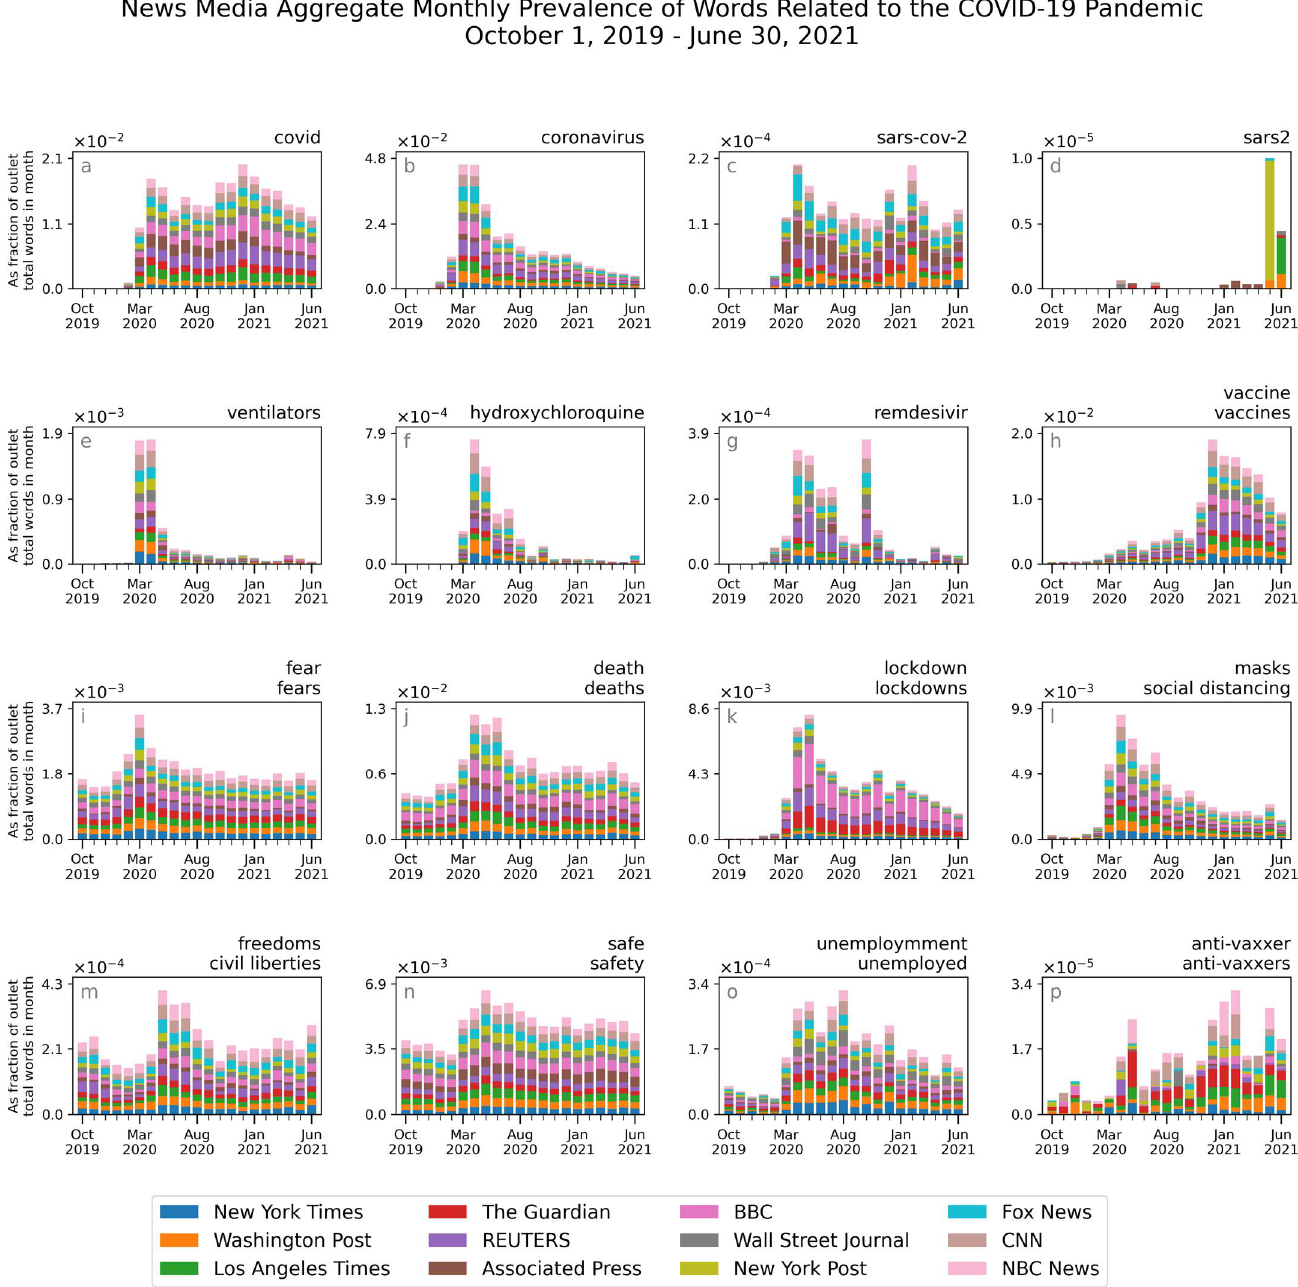
Figure 1. Monthly aggregate frequency of terms related to the COVID-19 pandemic in popular news media outlets.